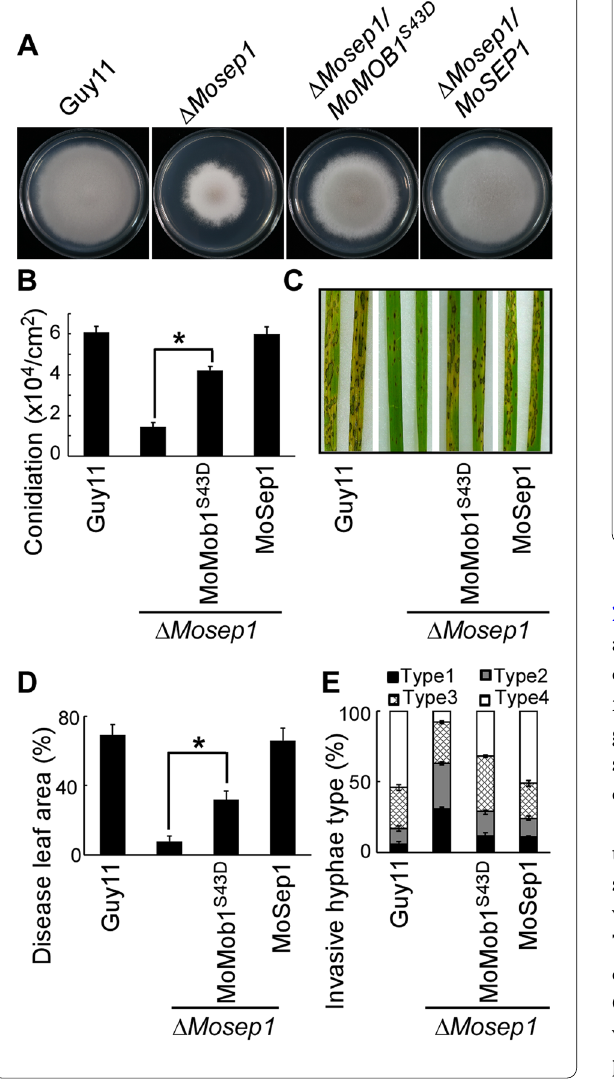
Fig. 4 MoMob1 S43D phosphomimic mutation partly suppresses defects of Mosep1 mutation. A Growth of the wild-type Guy11, mutant Δ Mosep1 and Δ Mosep1/MoMOB1 S43D , and complemented Δ Mosep1/MoSEP1 strains on CM medium. B Statistical analysis of conidia production on SDC medium cultured at 28 °C for 7 days in the dark followed by 3 days of continuous illumination under f﻿luorescent light. Error bars represent the standard deviations from three independent experiments. Asterisks indicate statistical significance according to a Student’s test ( p < 0.01). C Pathogenicity analysis using rice spraying assays. Images were photographed at 7 dpi. D Diseased leaf area analysis. Data were presented as a bar chart showing the percentage of lesion areas. Error bars represent the standard deviations from three independent experiments. Asterisks denote statistical significance according to the Student’s test ( p < 0.01). E Statistical analysis of infectious hyphae types (type 1, appressorium only; type 2, with primary invasion hyphal; type 3, secondary invasive hypha does not extend to neighboring plant cells; type 4, invasion hyphal extended into neighboring plant cells) on rice leaf sheaths. Rice leaf sheaths were inoculated with conidial suspensions and examined at 36 h post-inoculation (hpi). One hundred infectious hyphae were counted for each strain, and experiments were repeated three times. Error bars represent standard